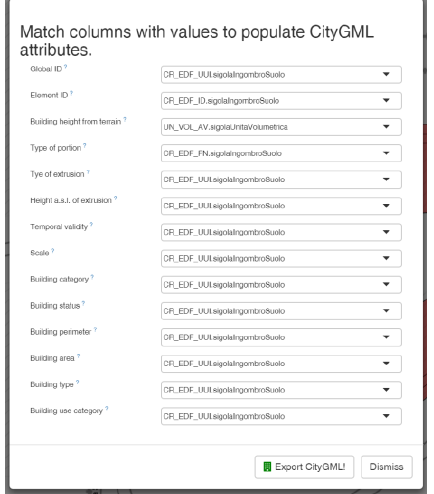
Figure 8. Attributes from shapefiles can be linked to attributes of CityGML model to be created.